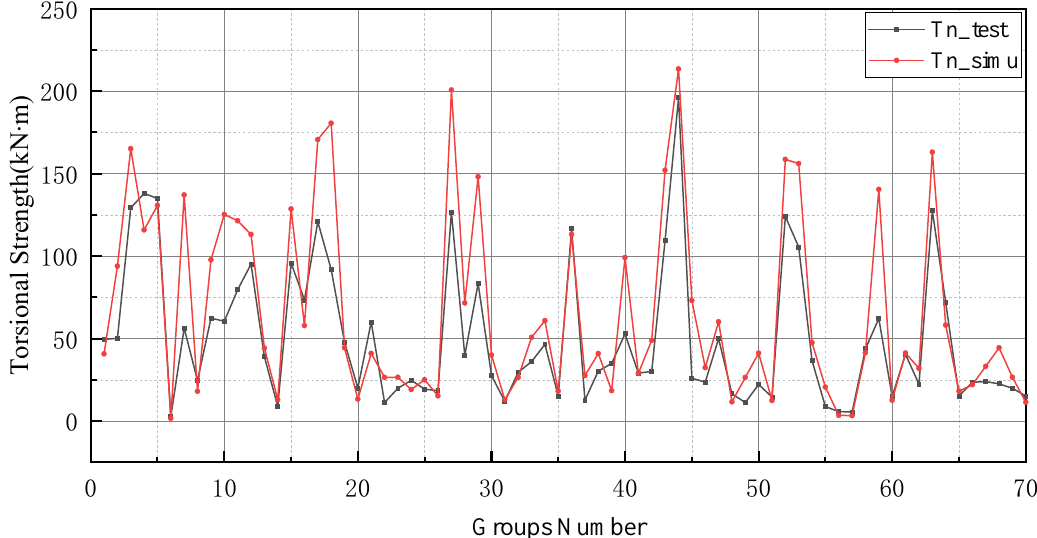
Figure 13. Prediction of torsional strength of BS-8110.